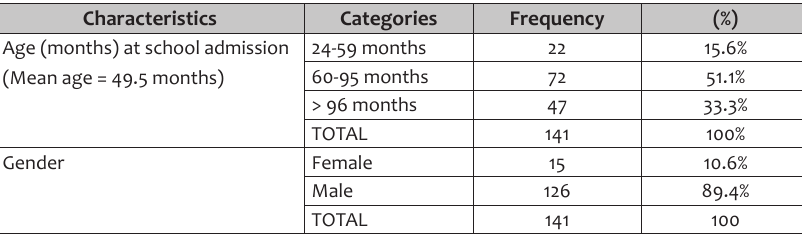
Table 1: General participant characteristics